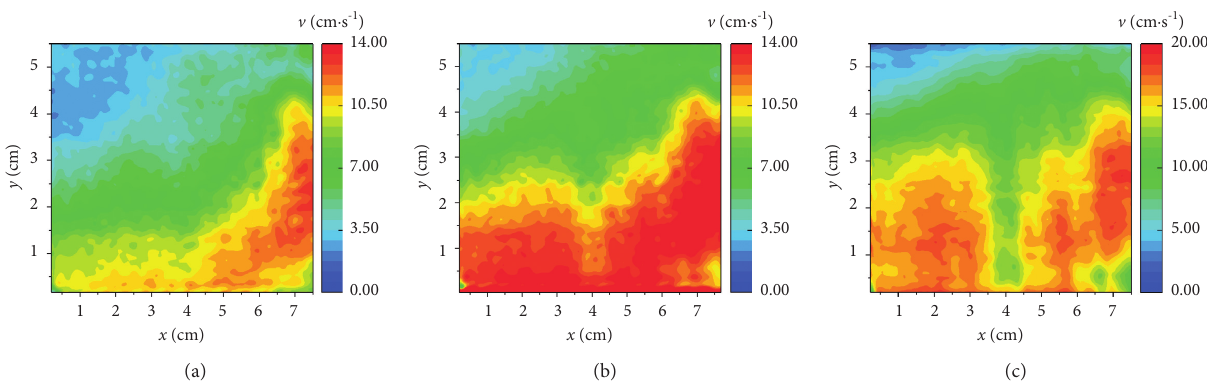
Figure 13: The distribution of the vertical turbulent intensities in different working conditions. (a) B25S. (b) B25M. (c) B25L.